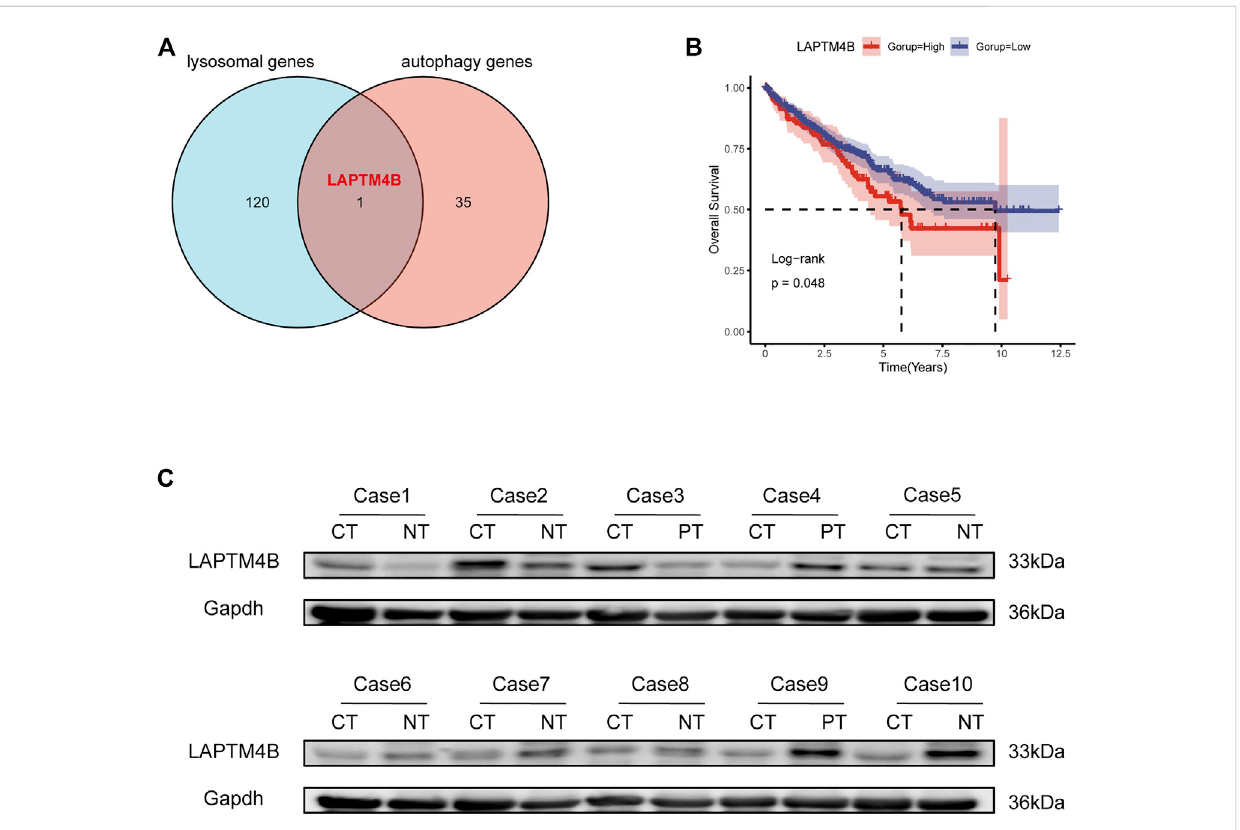
FIGURE 1 LAPTM4B expression and its prognostic value in ccRCC tissues. (A) The Venn diagram shows the common gene compared to the gene sets of the lysosomal and the regulating autophagy. (B) Log-Rank analysis shows that the overall survival of ccRCC (534 tumor samples) with high expression of LAPTM4B mRNA is worse; the group cut-off value is the upper quartile of LAPTM4B mRNA expression. (C) Western blot retrospectively veri fi ed the expression of LAPTM4B in 10 RCC patients. The expression of LAPTM4B in RCC tissues with Fuhrman grade Ⅳ is higher than that in the corresponding paracellular kidney tissues (Case 1-3). However, the expression of LAPTM4B in RCC tissues with Fuhrman grade Ⅰ is lower than that in adjacent renal tissues (Case 4-10) (CT: cancer tissues; NT: normal kidney tissue; PT: adjacent renal